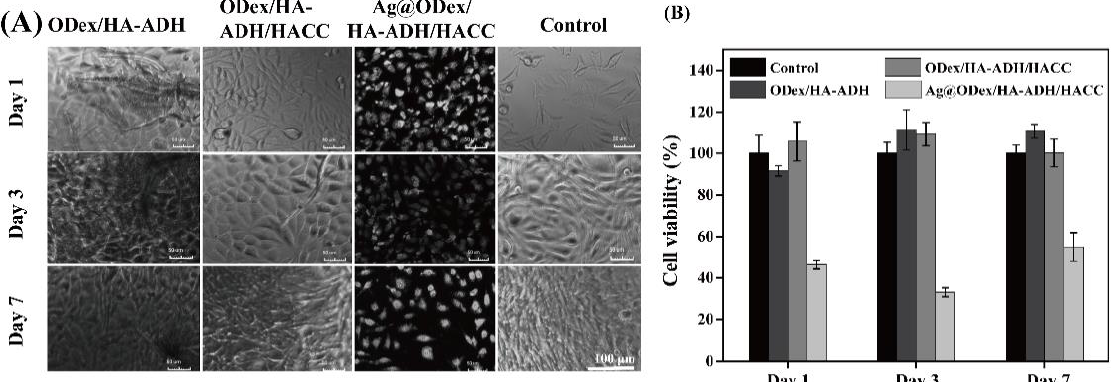
Figure 3. In vitro cytotoxicity of hydrogel. ( A ) The changes of cell morphology visualized using light microscopy 3-, 7- and 14-days post-treatment. ( B ) Cell viability of L929 cells cultured with ODex/HA-ADH, ODex/HA-ADH/HACC and Ag@ODex/HA-ADH/HACC hydrogel extract.